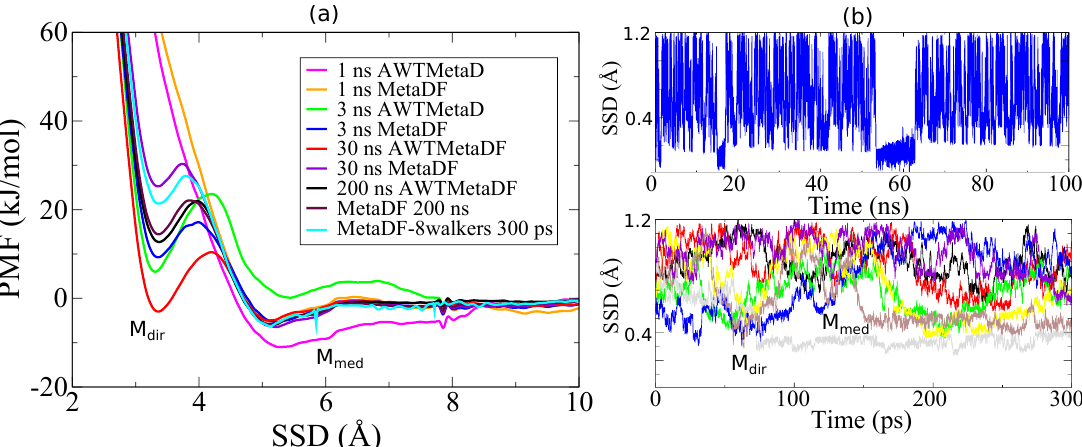
Figure 1. ( a ) Potentials of mean force (PMF) from CMD along the surface separation distance (SSD) for Lysine on anatase (101) calculated with AWTMetaD and MetaDF at different intervals of time. ( b ) Single (up) and 8 walkers (down) dynamics used to test the convergence. The two minima in the PMF correspond to a water mediated adsorption mode M med (SSD = 5 Å) and a direct surface contact mode M dir on the O br at SSD = 3.2 Å. AWTMetaD and MetaDF converge using a single walker in the long time range (200 ns) to the same PMF profile. The mode M med converges within 1 ns with an error of 0.6kJmol − 1 with MetaDF while AWTMetaD converges after 30 ns within the same error.